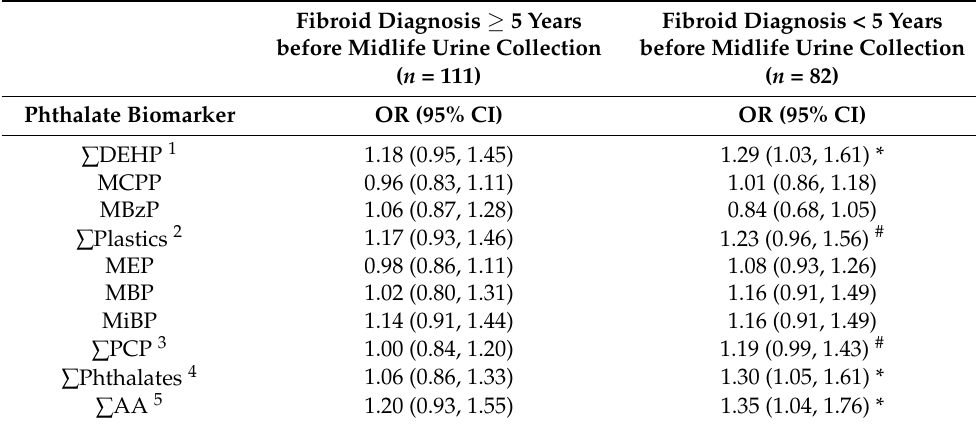
Table 3. Associations between urinary phthalate biomarker concentrations and timing of uterine fibroid diagnosis. Fibroid Diagnosis < 5 Years Fibroid Diagnosis ≥ 5 Years before Midlife Urine Collection before Midlife Urine Collection ( n = ( n = 111)